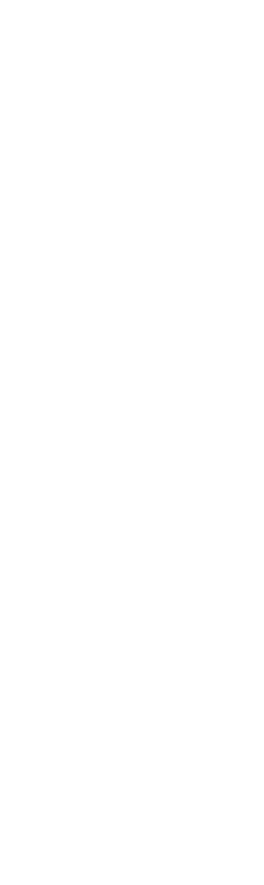
TABLE III Values of normalized etch rates, R{hk0}/ Rlo01 for the three